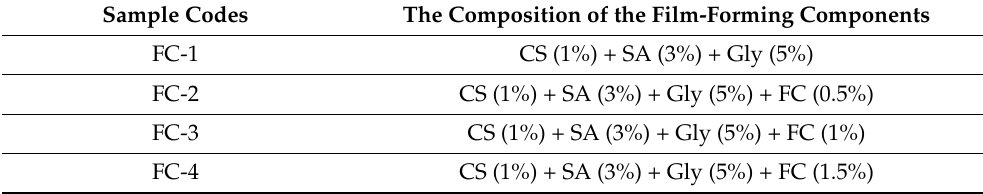
Table 1. Chemical composition of the CS–SA-based film-forming